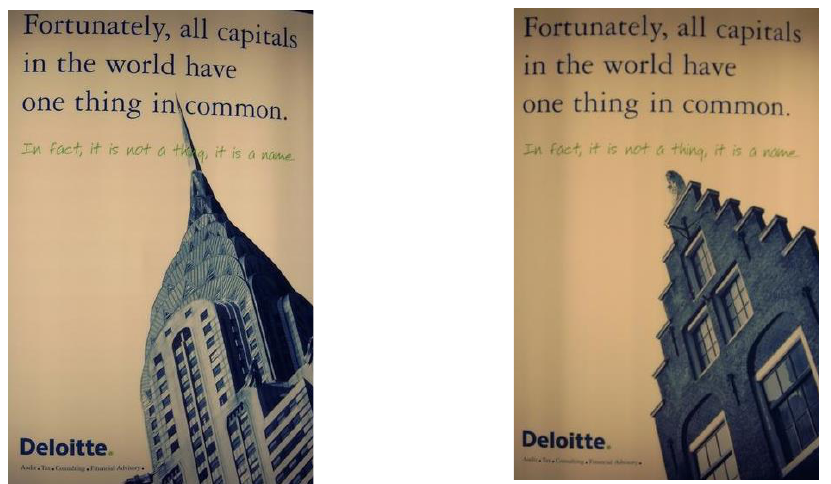
Figure 1. Marketing campaign of Deloitte at Amsterdam’s Schiphol Airport in April 2004. Source: Taylor and Derudder (2015).